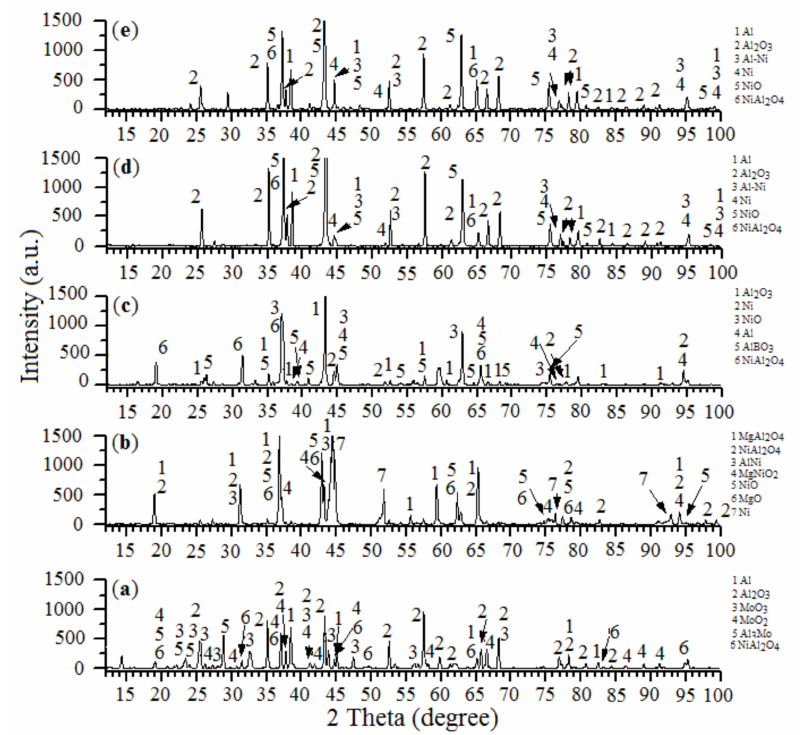
Figure 3. XRD analysis of the NiO–Al–Al 2 O 3 with the addition of H 3 BO 3 , MgO 2 , MoO 3 and different contents of elements: ( a ) 10.0% NiO—28.0% Al—40.0% Al 2 O 3 —22.0% MoO 3 , ( b ) 39.0% NiO—10.0% Al—30.0% Al 2 O 3 —7.0% Mg—14.0% MgO, ( c ) 87.0% NiO—12.6% Al—0.4% H 3 BO 3 , ( d ) 31.0% NiO—19.0% Al—50.0% Al 2 O 3 , ( e ) 28.0% NiO—42.0% Al—30.0% Al 2 O 3